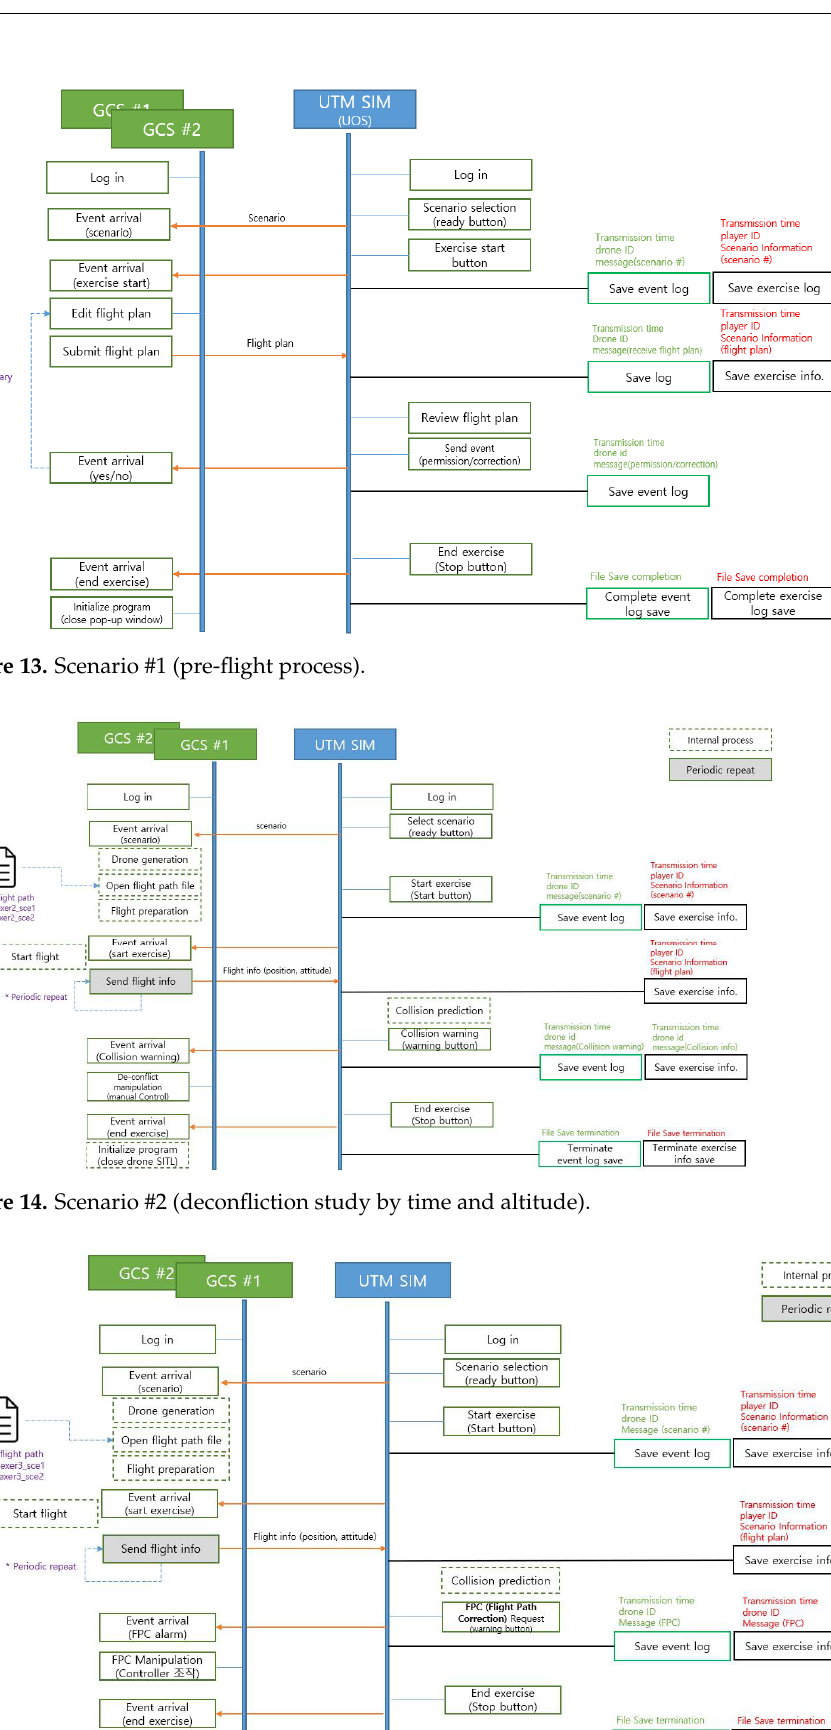
Figure 15. Scenario #3 (emergency by unexpected drone flights).